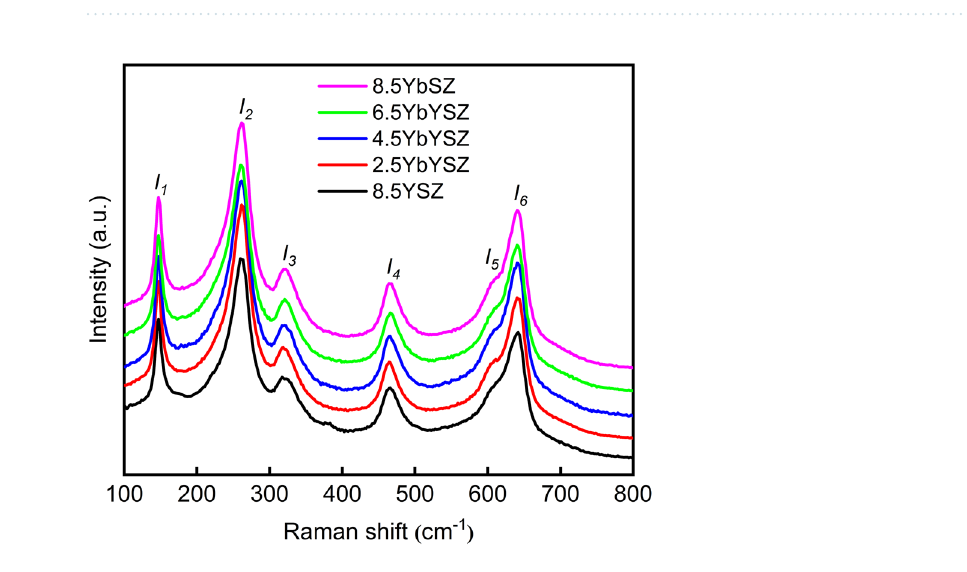
Figure 2. Raman spectra of x YbYSZ ( x = 0, 2.5, 4.5, 6.5, and 8.5)